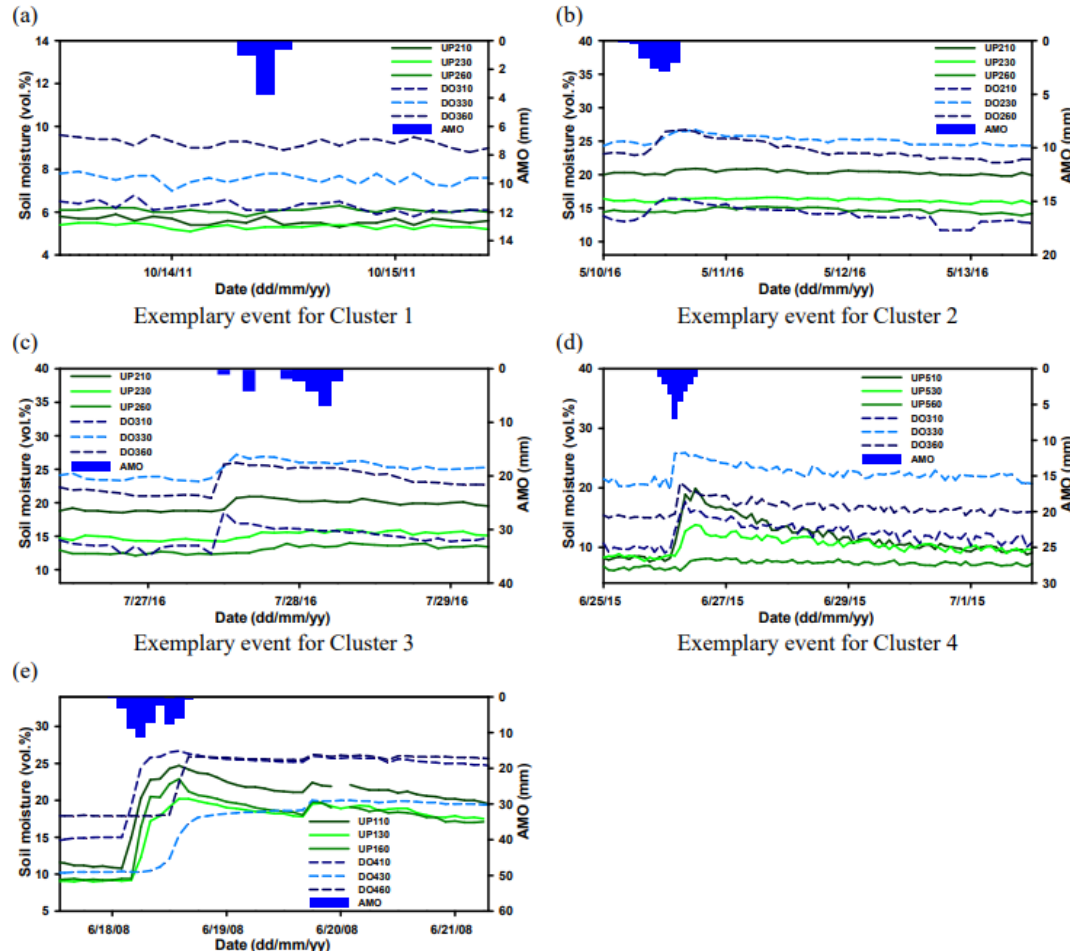
Figure A1. Exemplary event (rainfall and soil moisture) for Clusters 1, 2, 3, 4, and 5.